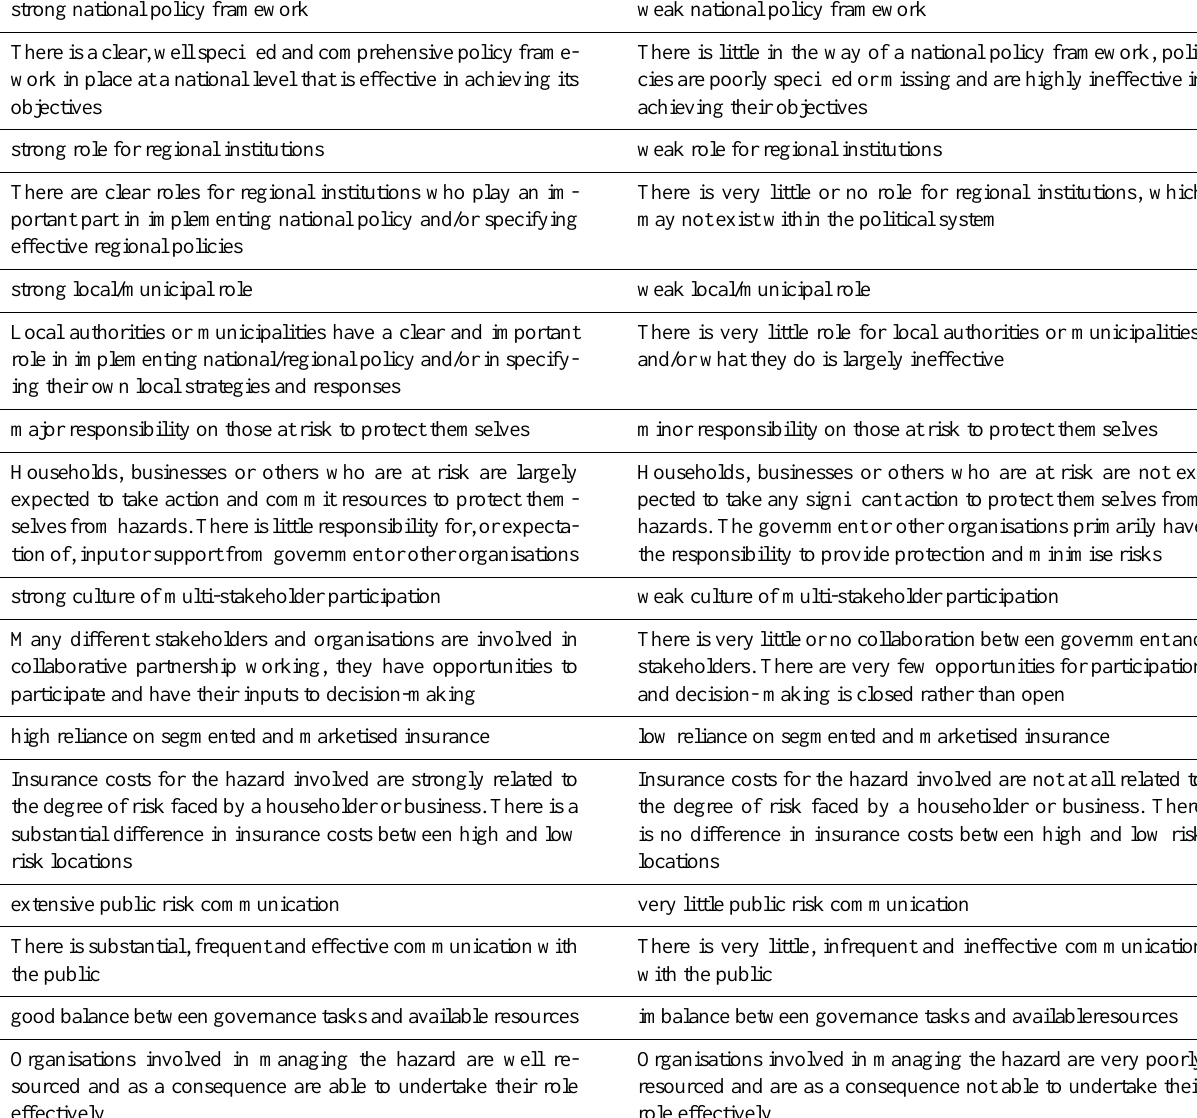
Table 1. Guidance on the eight risk governance characteristics captured in the risk governance characterisation template. strong national policy